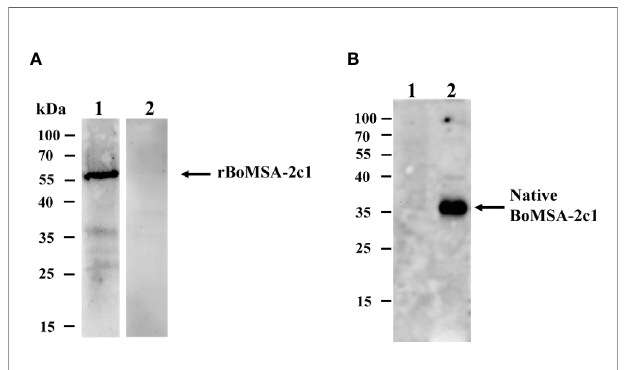
FIGURE 2 | Western blots of BoMSA-2c1. (A) Recombinant BoMSA-2c1 subjected to probing with water buffalo serum infected with (lane 1) and without (lane 2) B orientalis . (B) Immunoblots of the native BoMSA-2c1 protein in parasite lysates. Lane 1, lysate of the uninfected buffalo erythrocytes does not exhibit reaction with polyclonal BoMSA-2c1 antibody. Lane 2, a speci fi c 37-kDa band in parasite lysate subjected to probing with rBoMSA-2c1 antiserum.